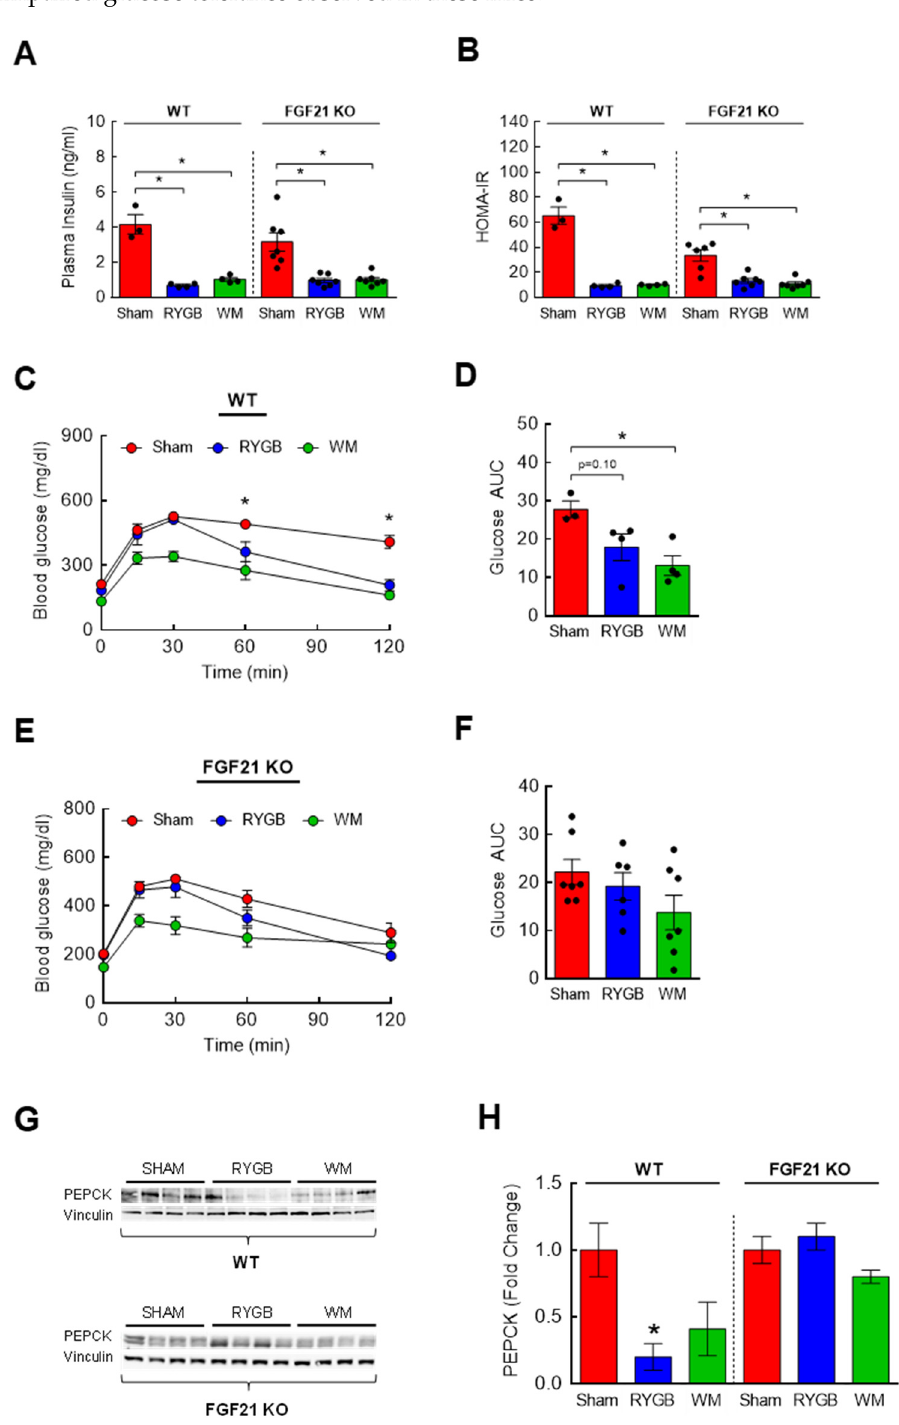
Figure 6. The effects of FGF21 on insulin sensitivity and glycemic control in response to RYGB. Eight-week-old male WT ( n = 3–4/group) or FGF21 KO mice ( n = 7–8/group) were fed a two-choice